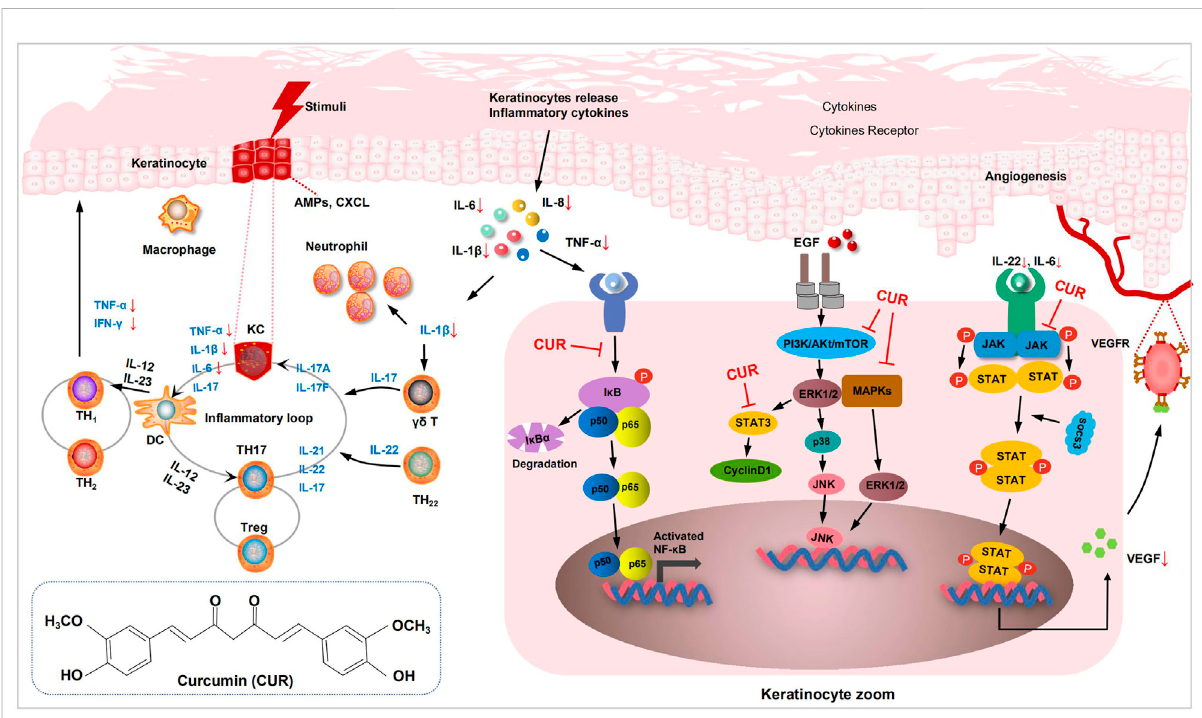
FIGURE 2 Diagram of the mechanism of curcumin (CUR) in in vitro preclinical studies. Mechanism of CUR in psoriatic dermatitis. The cytokines IL-12 and IL-23releasedbyDCsstimulateTh1cellstoproduceTNF- α andINF- γ ,andstimulateTh17cellstoproduceIL-22andothercytokines.IL-17andTNF- α inducedKCstoproducepro-in fl ammatoryfactors,suchasIL-6andIL-8,causingmassiveaccumulation ofneutrophilsandactivationoftheNF- κ B signaling pathway. IL-22 secreted by Th17 cells activates the JAK-STAT3 and MAPK signaling pathway. CUR inhibited IL-22 induced phosphorylation of STAT3, and reduces vascular proliferation by inhibiting VEGF. CUR reduced the secretion of in fl ammatory factors by inhibiting KCs and further blocks the activation of the NF- κ B, JAK-STAT3 and MAPK signaling pathway. DCs, dendriticcells; KCs, keratinocytes;VEGF, vascular endothelial growth factor; Th17, T helper 17; IL, interleukin; NF- κ B, nuclear factor- κ B; JAK-STAT3, (Janus tyrosine Kinase)-(Signal Transducer and Activator of